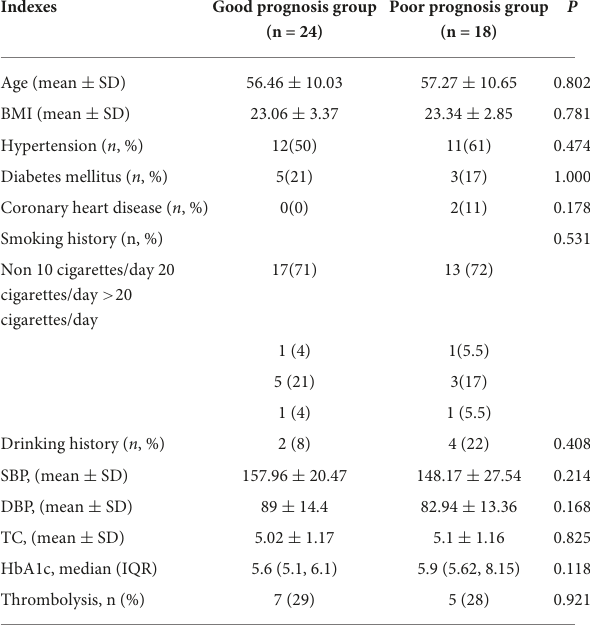
TABLE 1 Baseline characteristics between good and poor prognosis